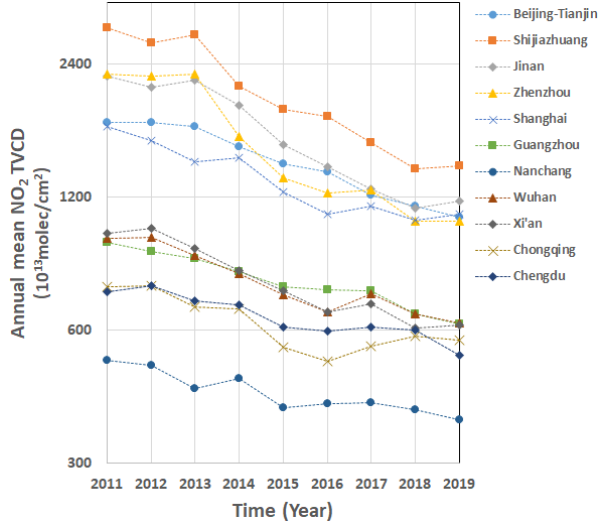
Figure A1. Time series of annual mean NO 2 TVCDs, derived from de-seasonalized monthly OMI data, for each of the 11 regions, plot- ted on a semilogarithmic